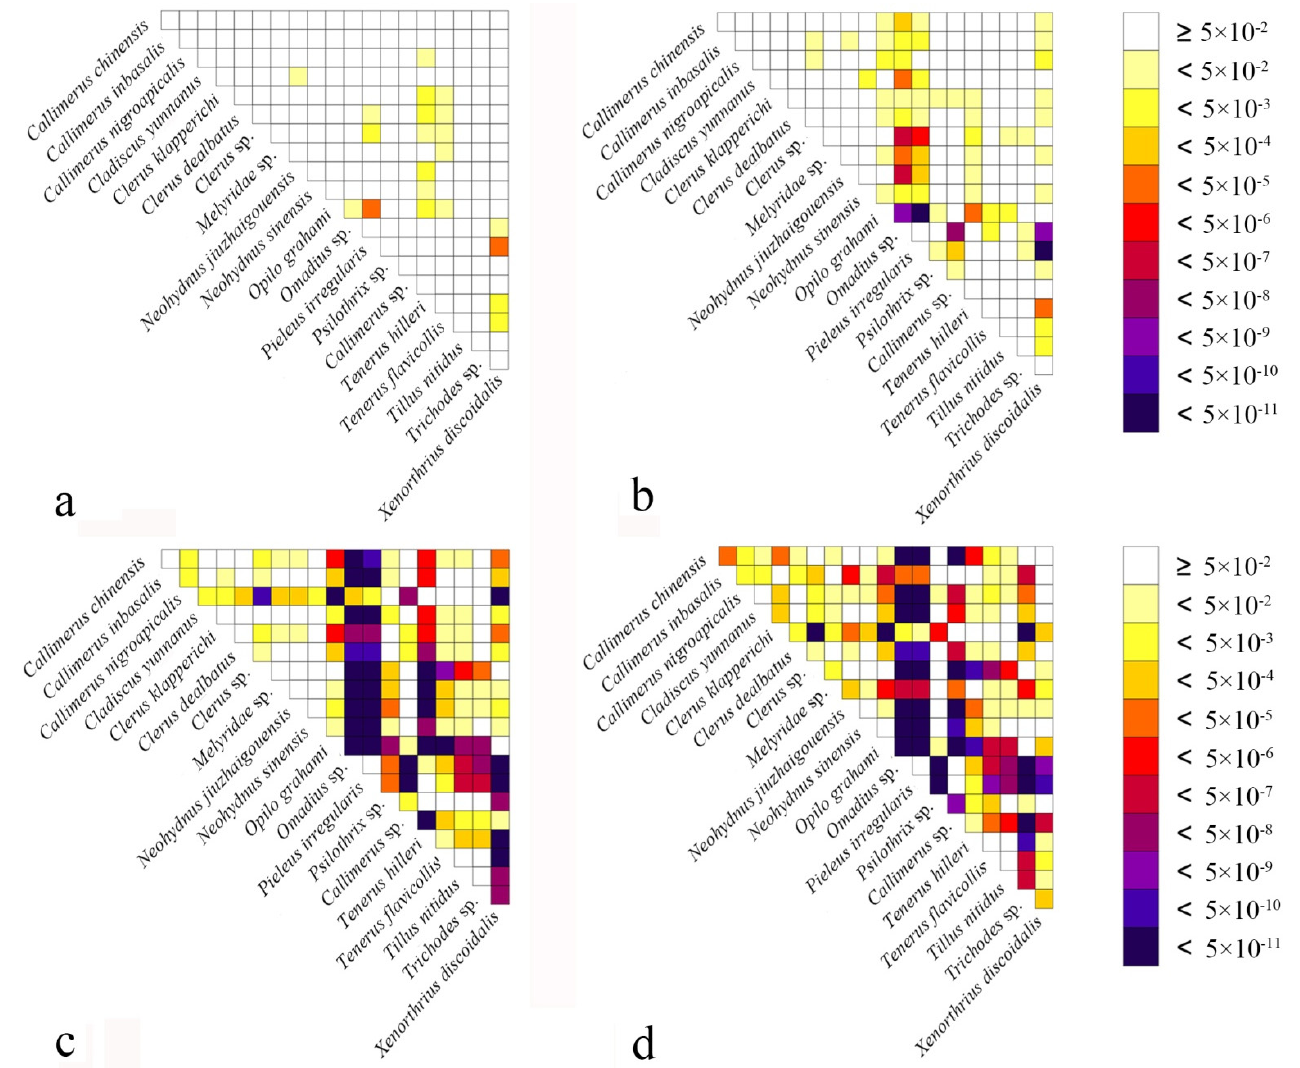
Figure 1. Heterogeneous sequence divergence of mitochondrial genomes of Cleridae resulting from pairwise comparison of four aligned datasets: ( a ) PCG12rRNA; ( b ) PCG; ( c ) PCGrRNA; ( d ) PCGRNA. The dark colors indicate the higher randomized accordance, whereas the lighter colors indicate the opposite. All taxa names are listed to the right of the heat map. Although cells specify p -values > 0.05, indicating that corresponding pairs of nucleotide sequences do not violate the assumption of global stationery and homogeneity conditions.